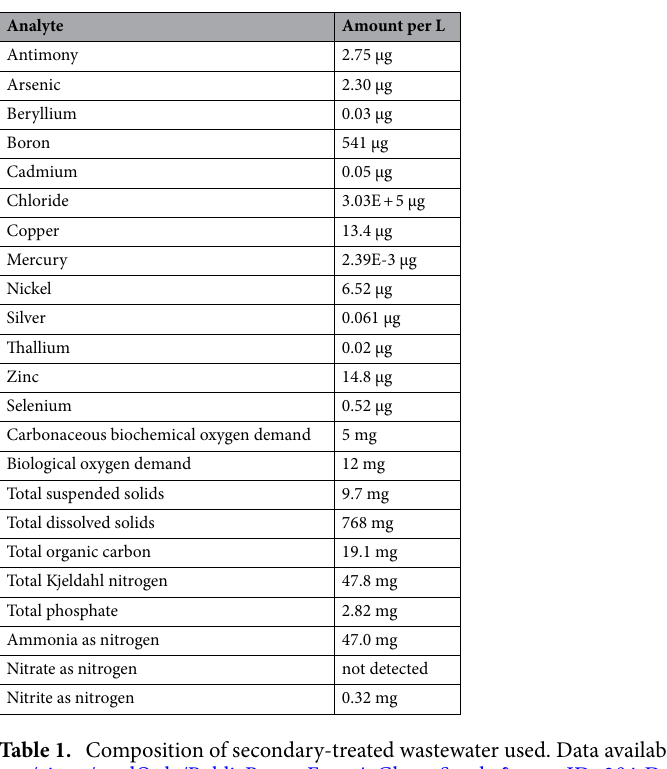
Table 1. Composition of secondary-treated wastewater used. Data available at http:// ciwqs. water boards. ca. gov/ ciwqs/ readO nly/ Publi cRepo rtEsm rAtGl anceS ervlet? repor tID= 2& isDri lldown= true& docum entID= 18937